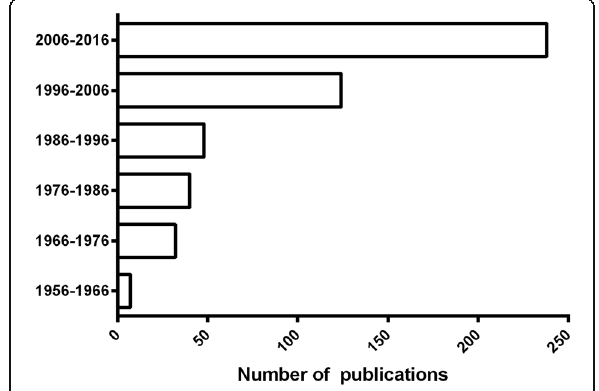
Fig. 2 Number of scientific publications on Loxosceles during the